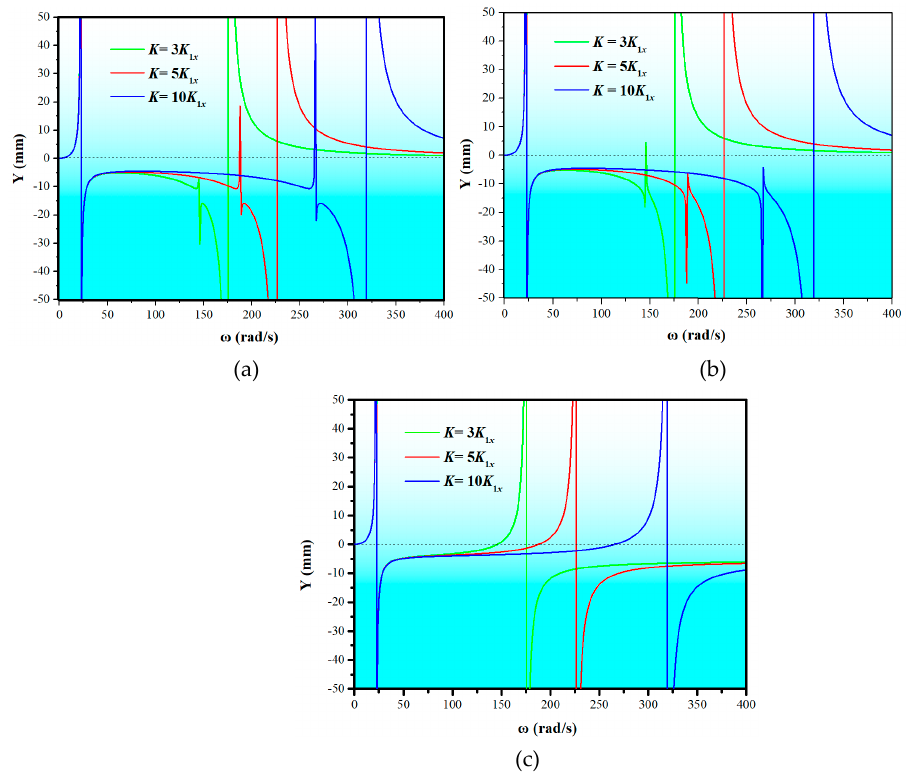
Figure 8. Amplitude-frequency characteristic curves in the x direction.